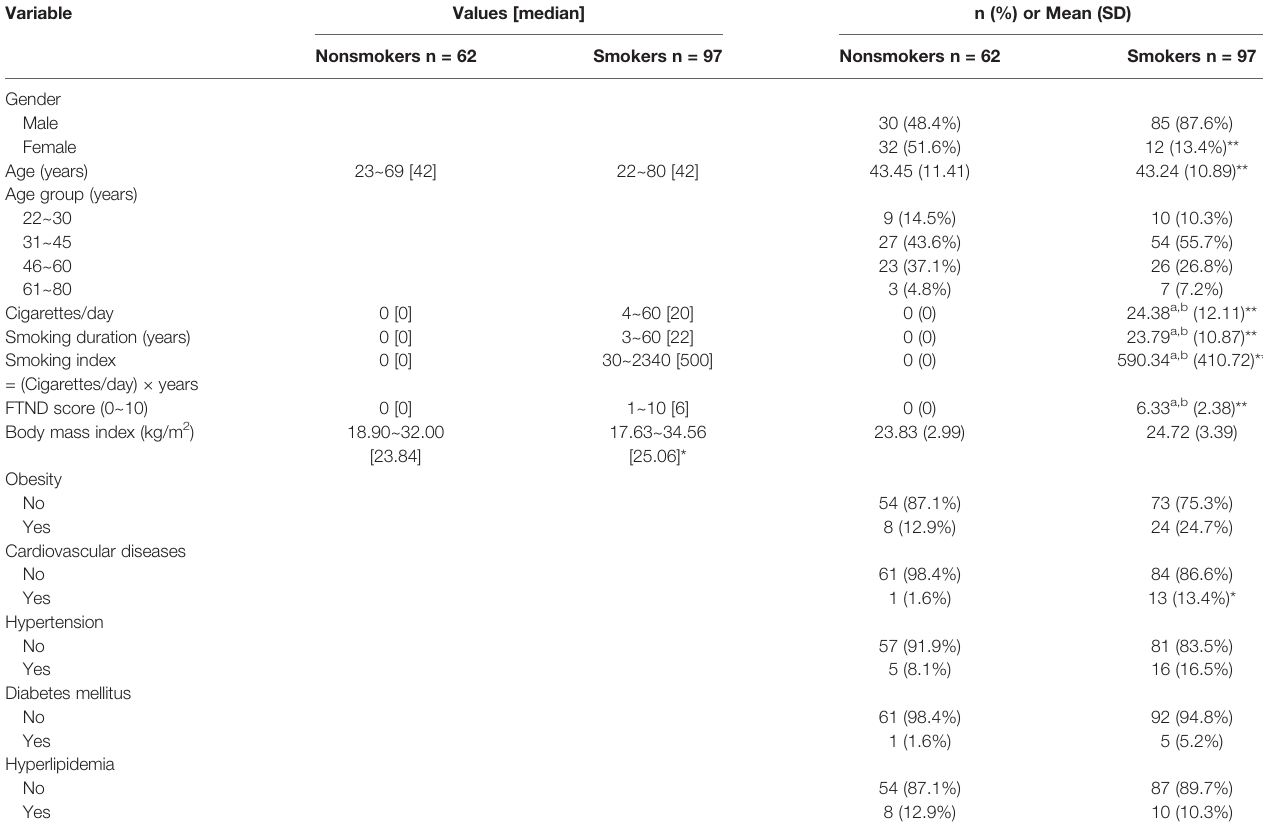
TABLE 1 | Baseline demographic data (n =